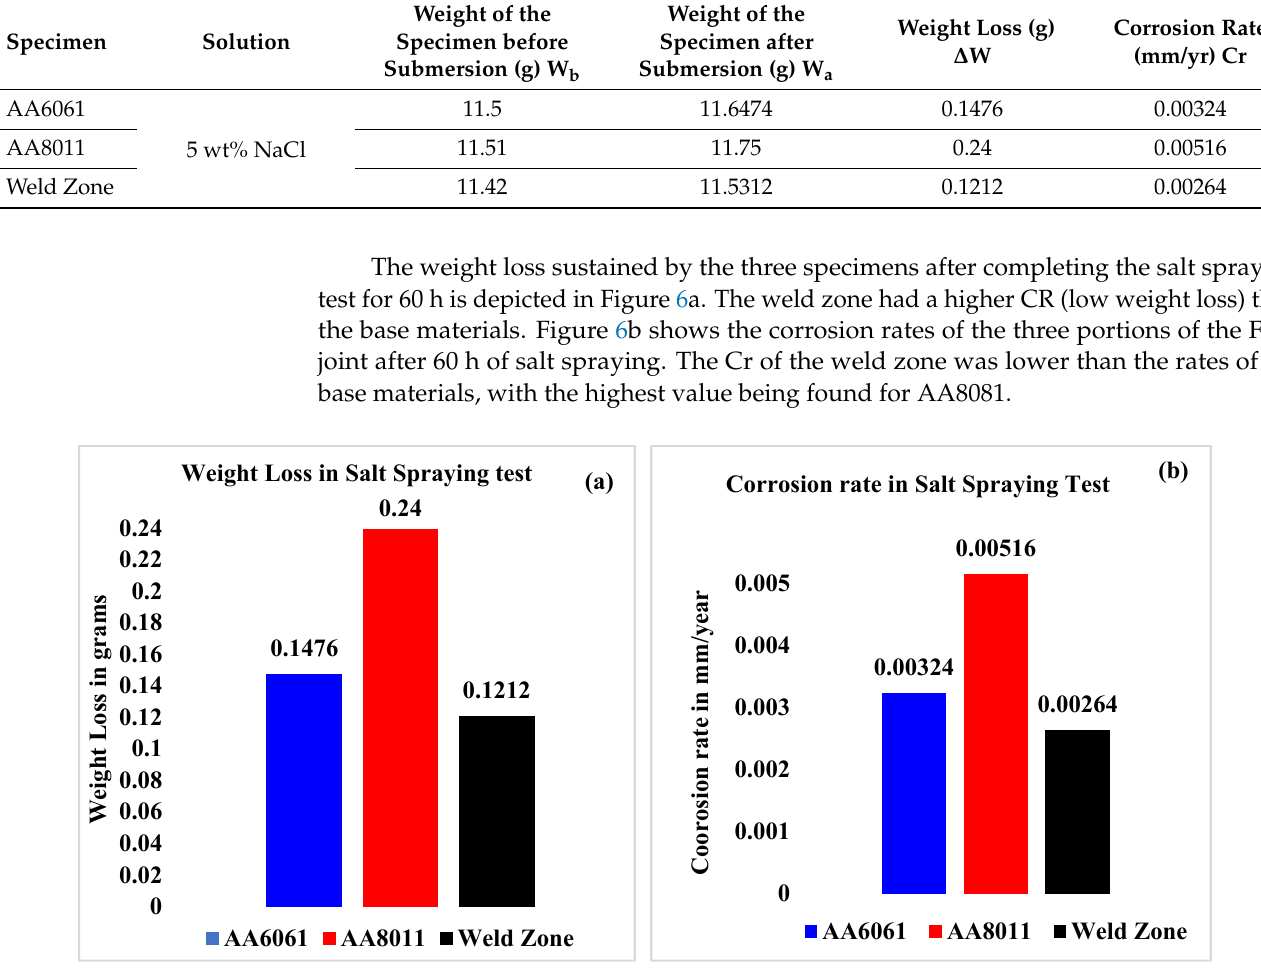
Figure 6. ( a ) Weight loss values and ( b ) corrosion rates of the base materials and weld region in salt spraying